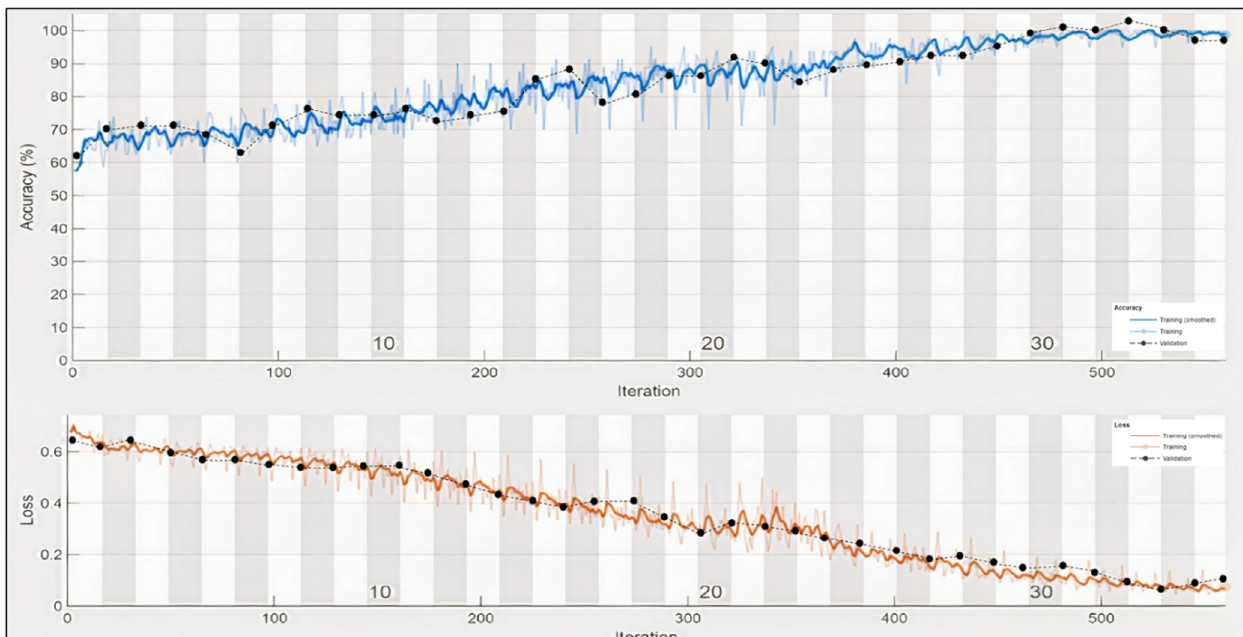
Figure 23. Training progress of liking label.